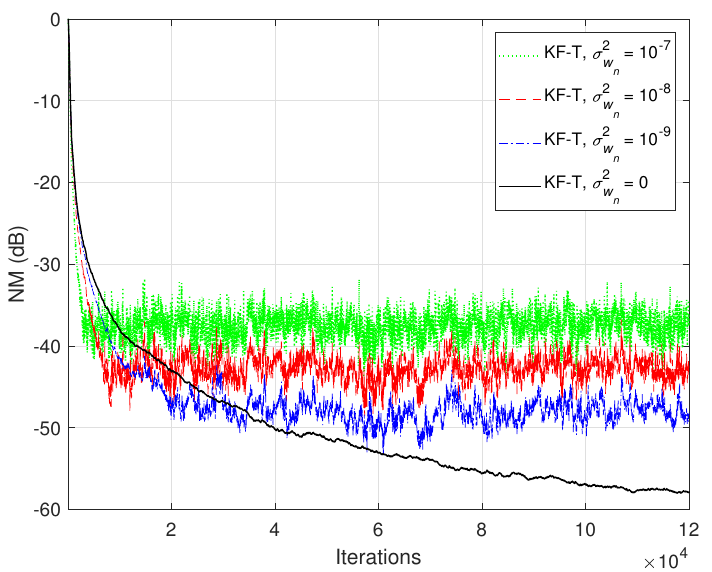
Figure 1. Normalized misalignment (NM) of the KF-T using different values of σ 2 w for the identification of the global impulse response, h ( t )